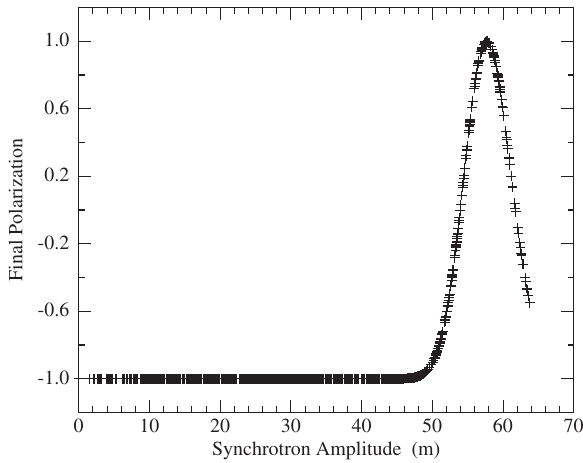
FIG. 19. Final polarization values following a frequency scan as described for the measurements of Fig. 8 displayed here as a function of the synchrotron amplitude parameter A for 1000 tracks.